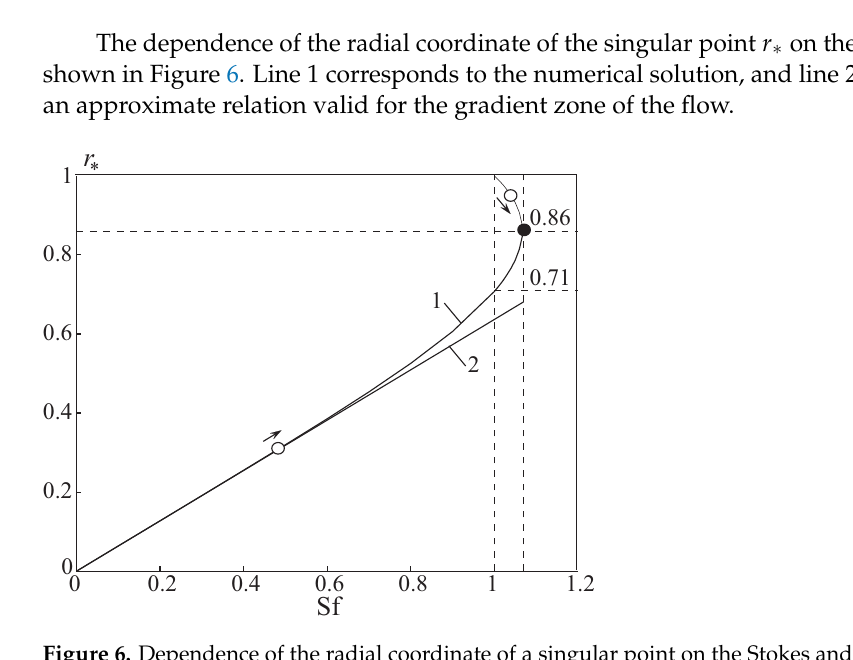
system. As Sf increases, the singular point moves along line 1 obtained by the numerical solution. For small r and Sf, line 1 is approximated with good accuracy by line 2. The position of the outer boundaries of the gradient zone is found at r ≈ 0.7, which takes place at Sf ≈ 0.7.